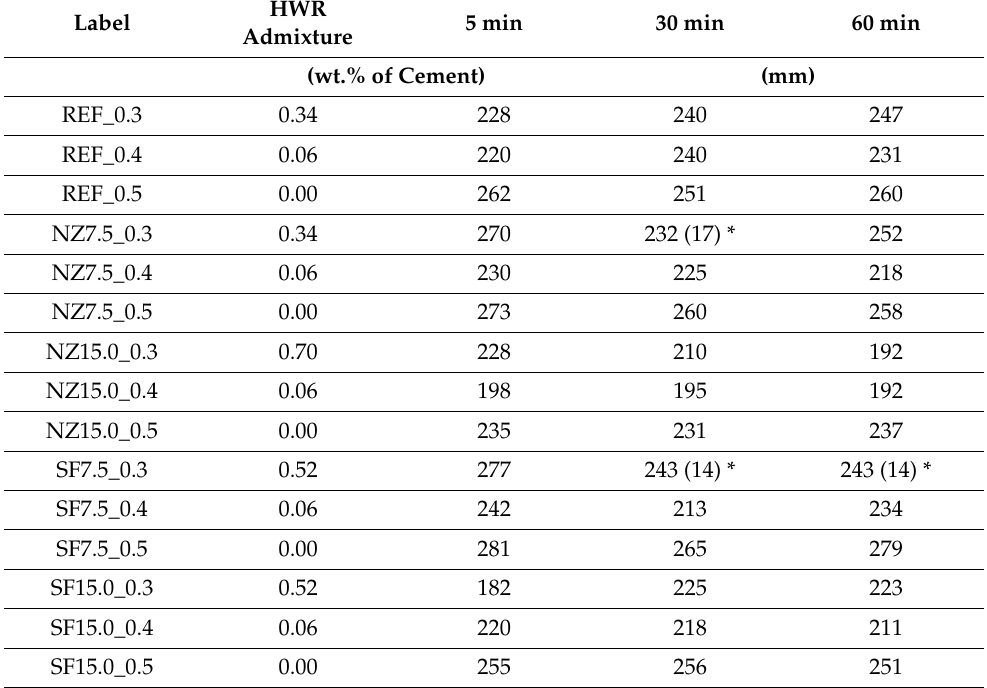
Table 3. Results of consistency in Haegermann’s